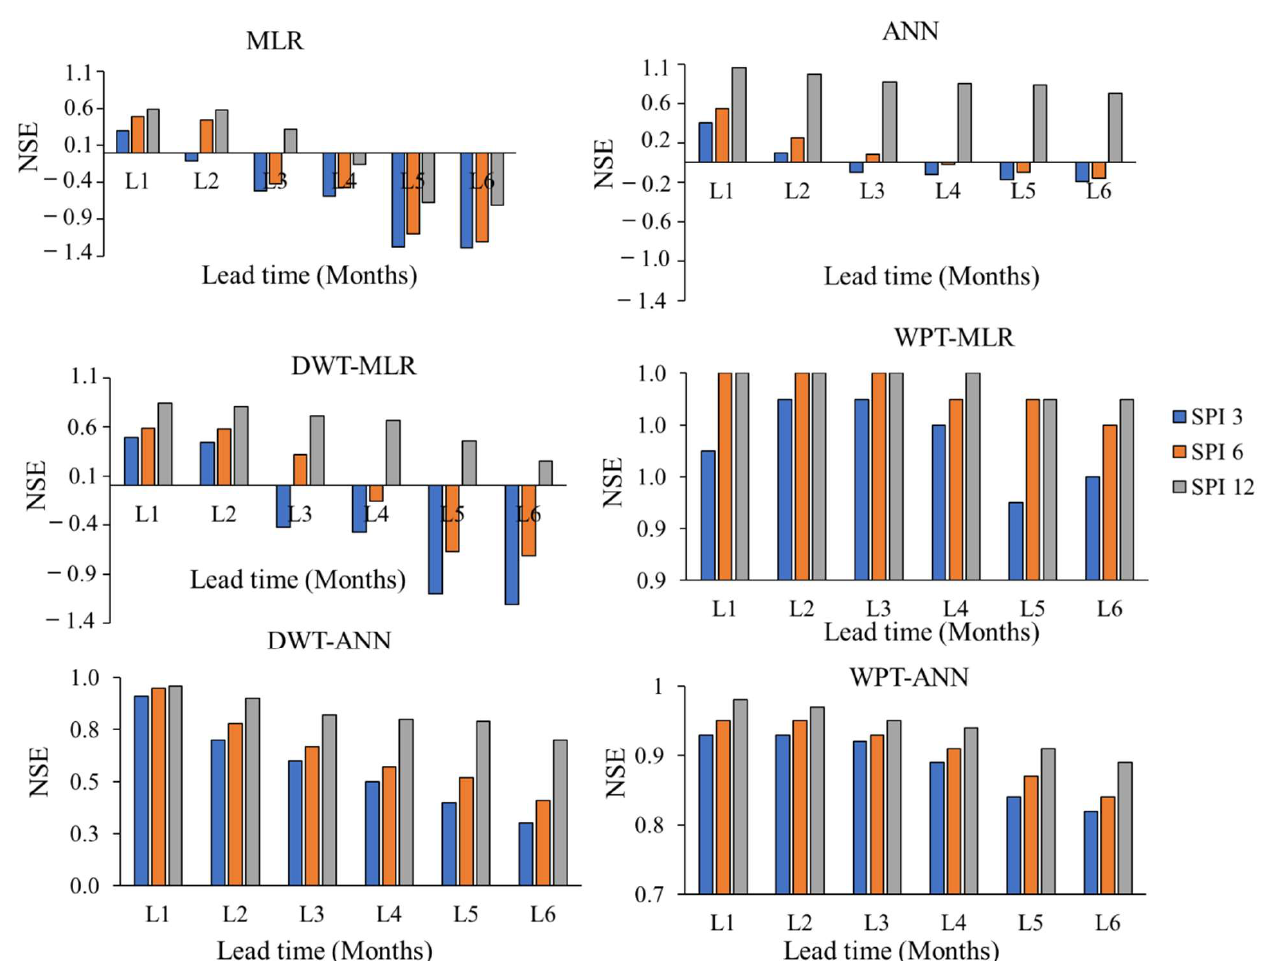
Figure 7. Performance of the models under different scales for different lead times.